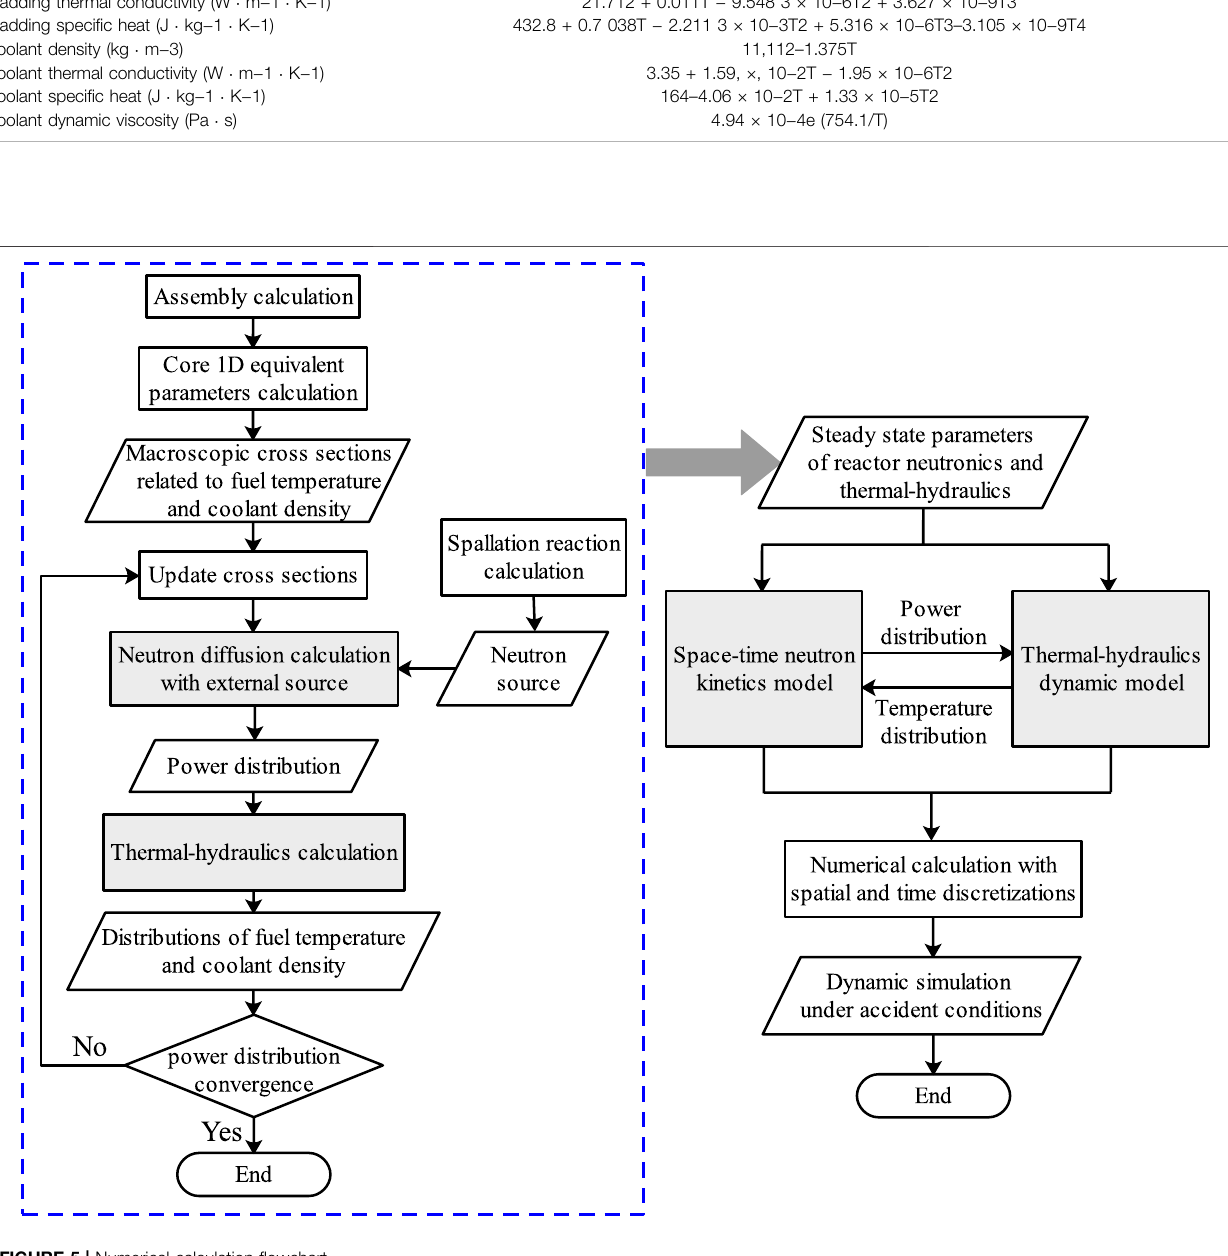
FIGURE 5 | Numerical calculation fl